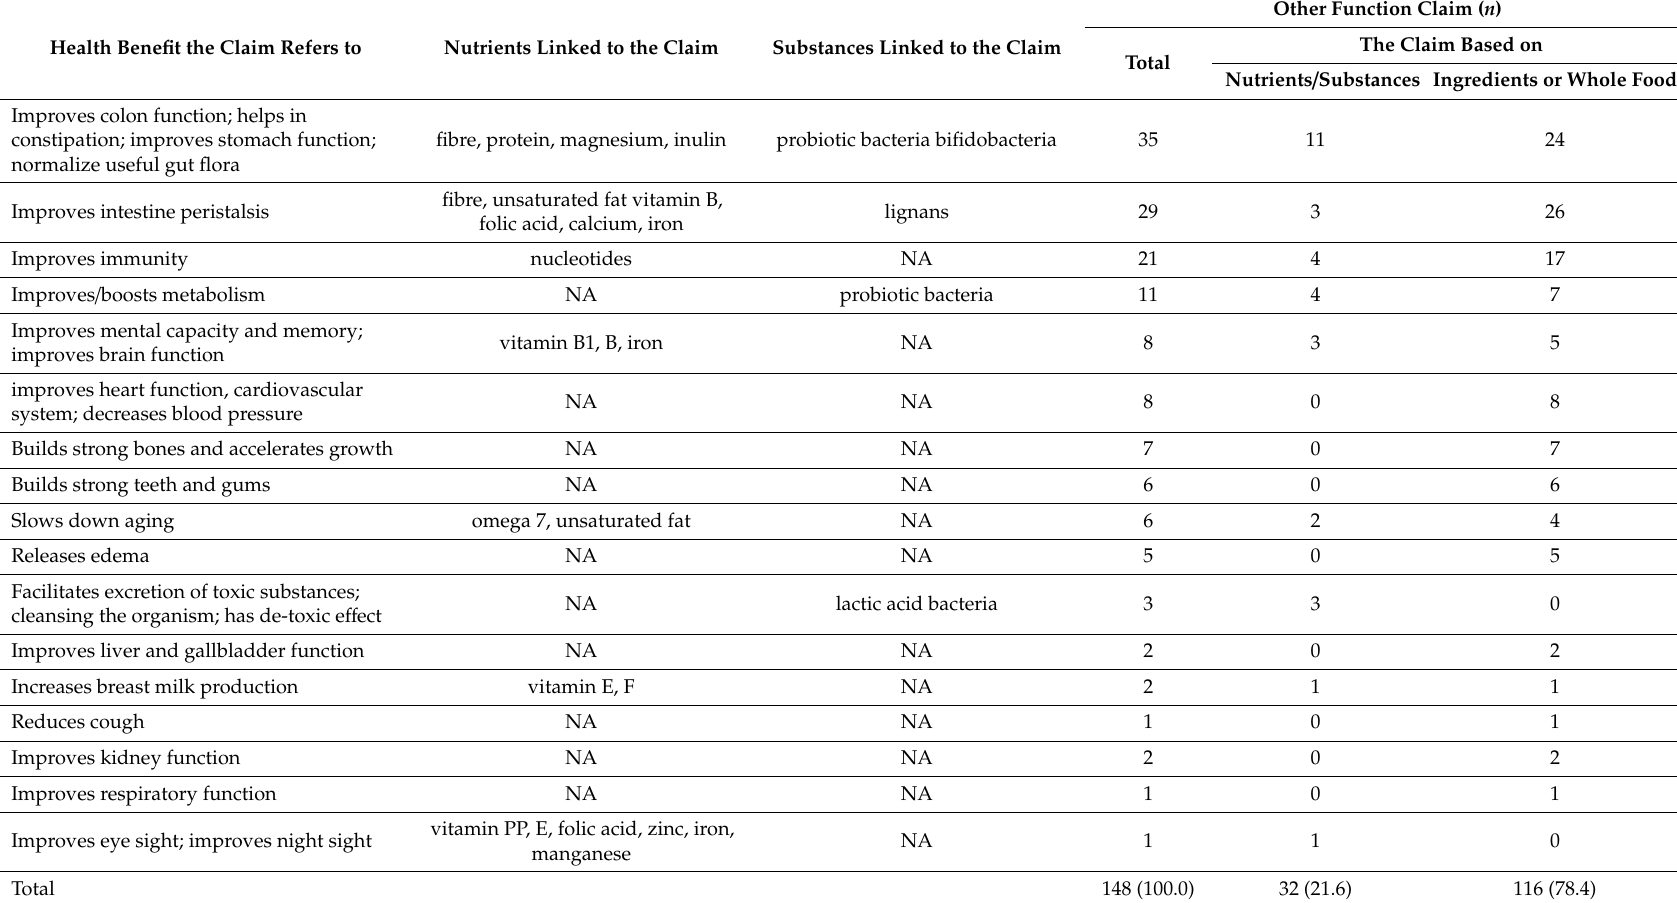
Table A3. Other function claims by attributable health